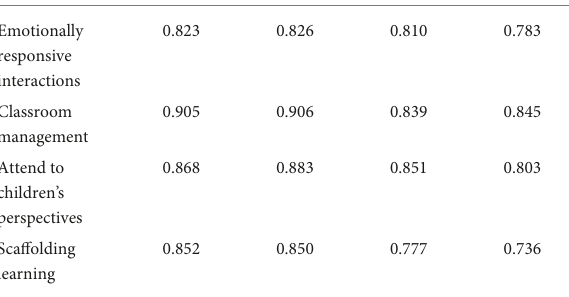
TABLE 3 Construct validity of the questionnaire “Facilitating strategies of teacher-child interaction”.